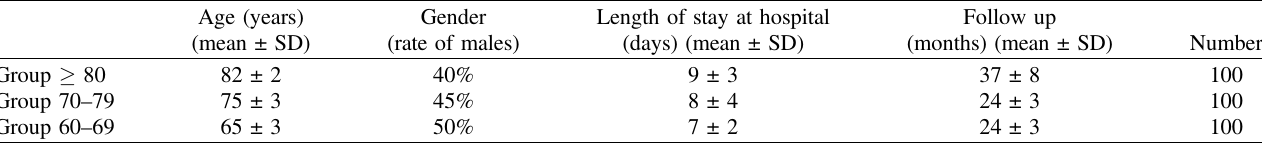
Table 1. Demographics of the study population, length of stay and follow up.